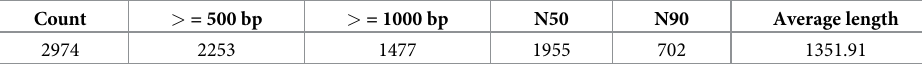
Table 2. Assembled unigenes from transcriptome analysis.